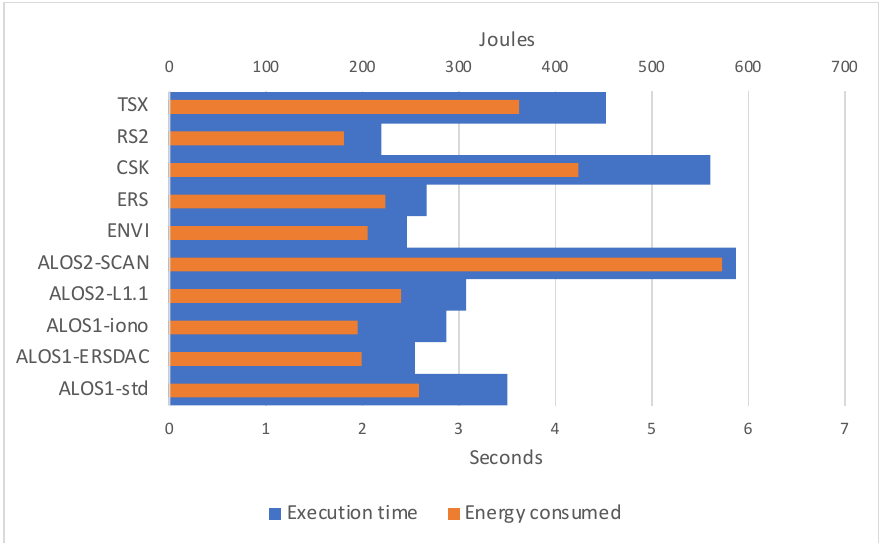
Figure 10. Graphical representation of the execution times for considered datasets on V100 hardware configuration, and relative joules of energy